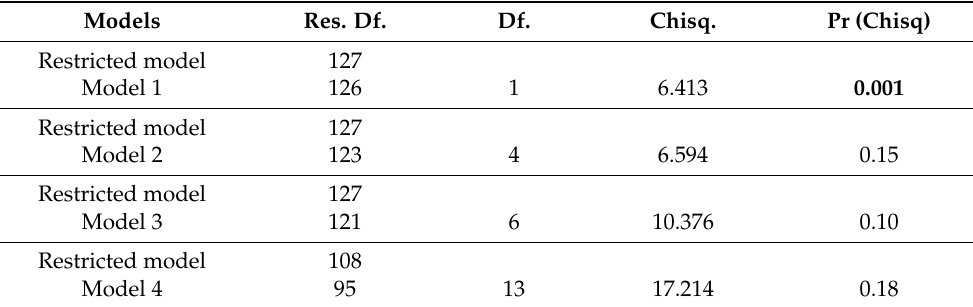
Table 6. Model fitting comparison test using multiple logistic ordinal regression approach. Models Res.